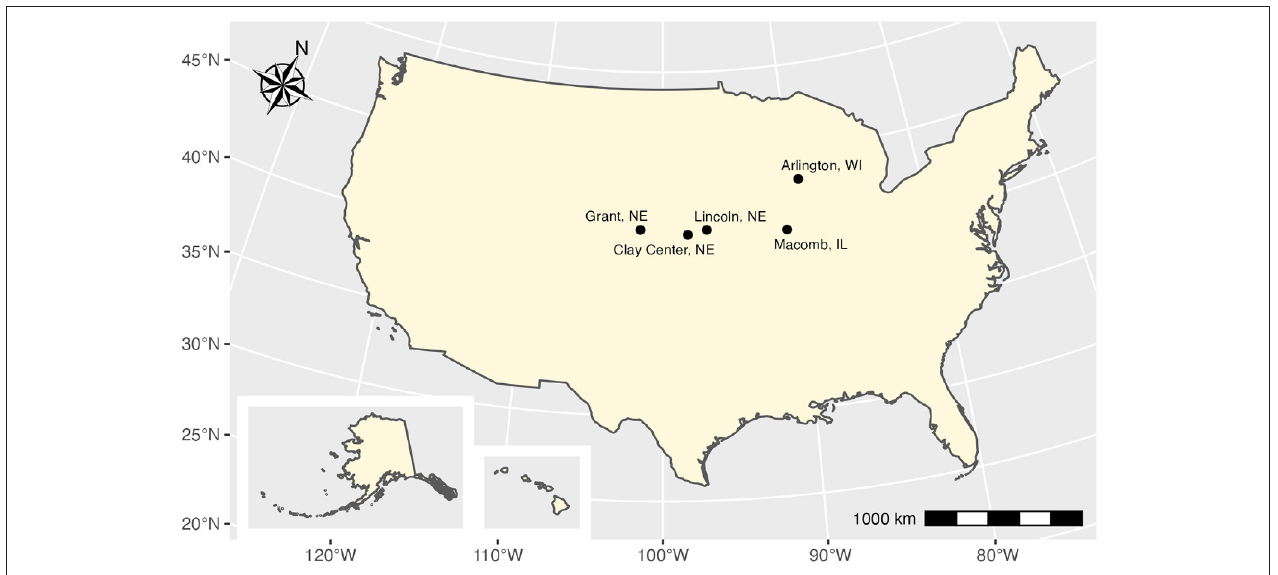
FIGURE 1 | Field research locations in the North Central United States